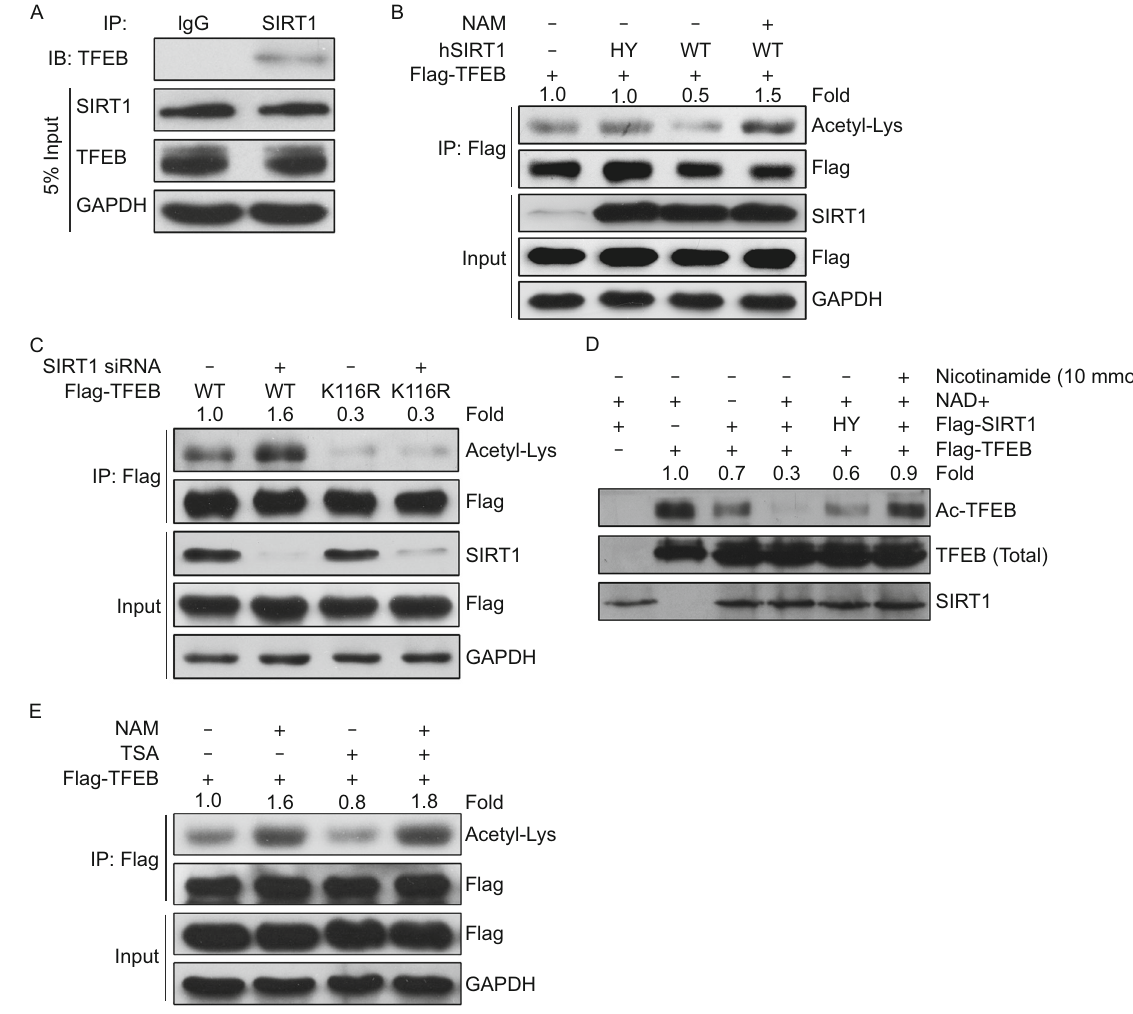
Figure 4. TFEB is a deacetylation substrate of SIRT1. (A) TFEB interacts with SIRT1. Endogenous coimmunoprcipitation assay was conducted with SIRT1 antibody and endogenous TFEB was detected by its speci fi c antibody. (B) Catalytic activity of SIRT1 is required for deacetylation of TFEB. Flag-tagged TFEB was co-transfected into HEK293T cells with wild-type SIRT1 (WT) or its catalytically inactive mutant H363Y (HY), followed by additional treatment with or without NAM before harvest. Acetylation levels of TFEB were measured by IP Western blotting analysis. Values were expressed as fold changes relative to TFEB-WT without SIRT1 overexpression and normalized to IP-Flag. (C) Deacetylation mimic of TFEB (K116R) counteracts SIRT1 knockdown effects